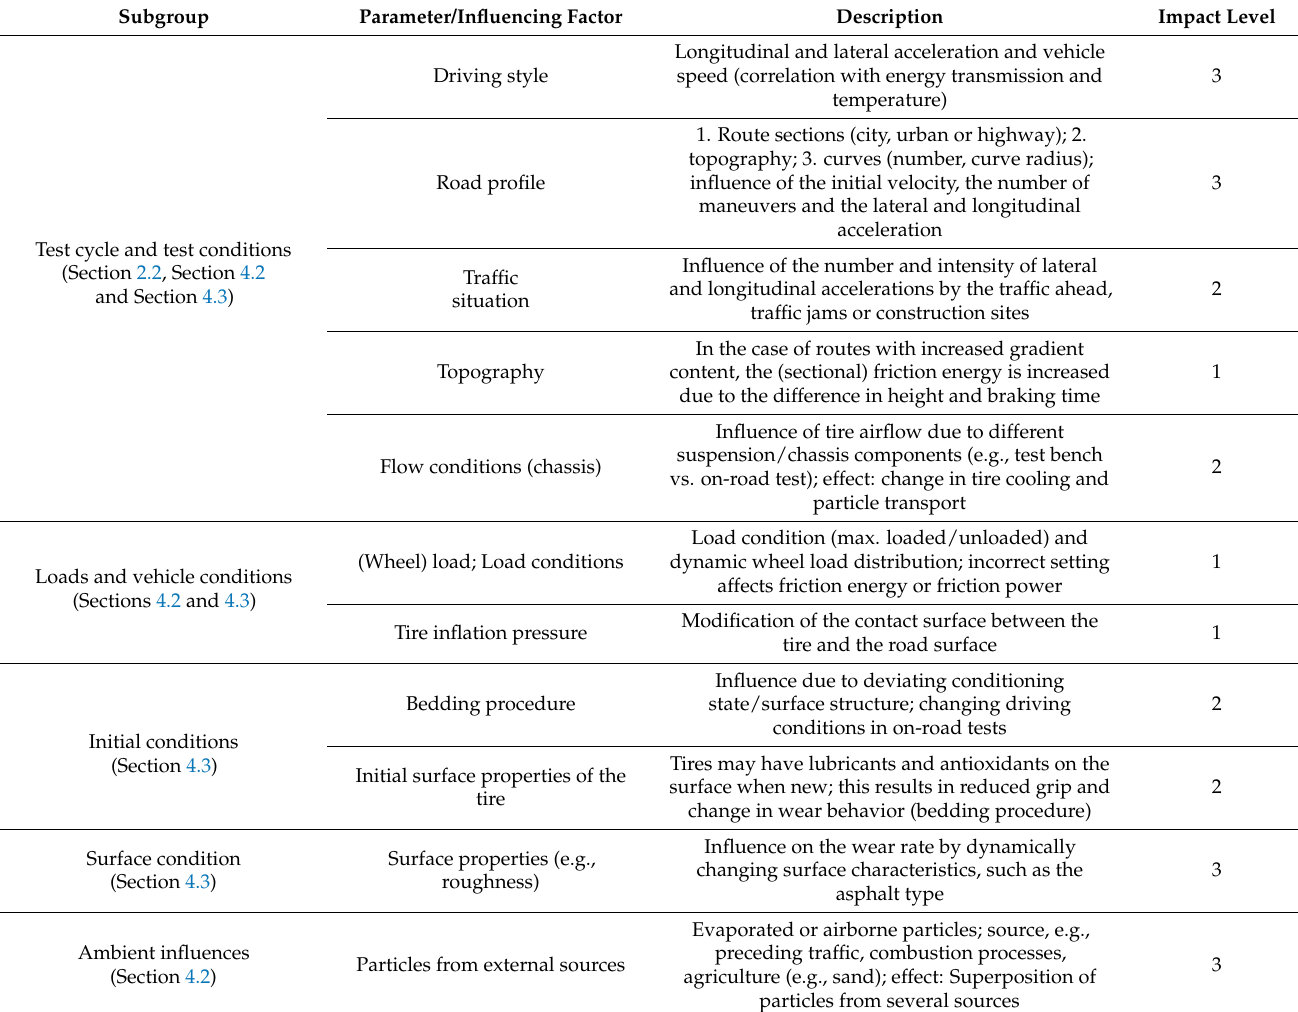
Table 3. Influencing factors on the formation process, the particle transport and the measurement capability of tire wear particle emissions under varying test